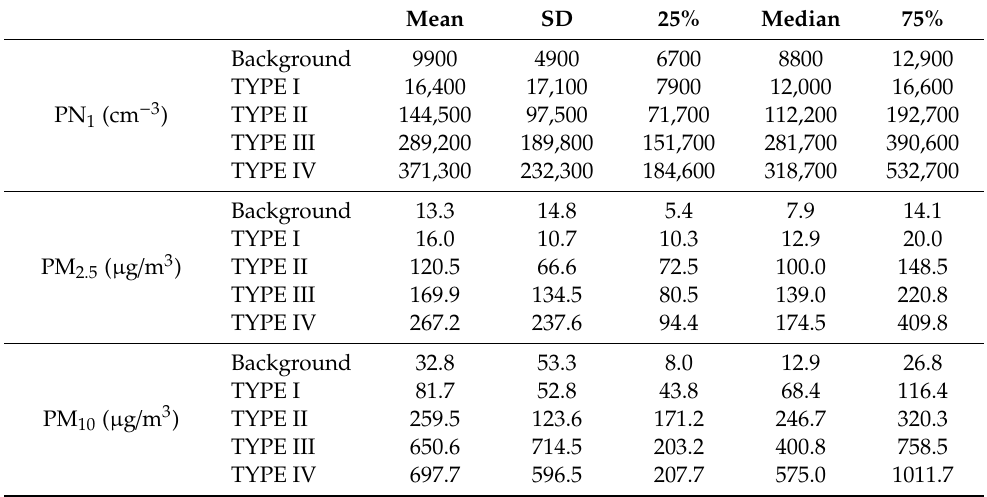
Figure 3. Indoor particle number and mass concentrations in Jordanian homes for background periods (BG) and the categorized indoor activities (TYPEs I, II, III, IV): ( a ) mean and ( b ) median. Table 3. Particle number and mass concentrations for the categorized indoor activities across all